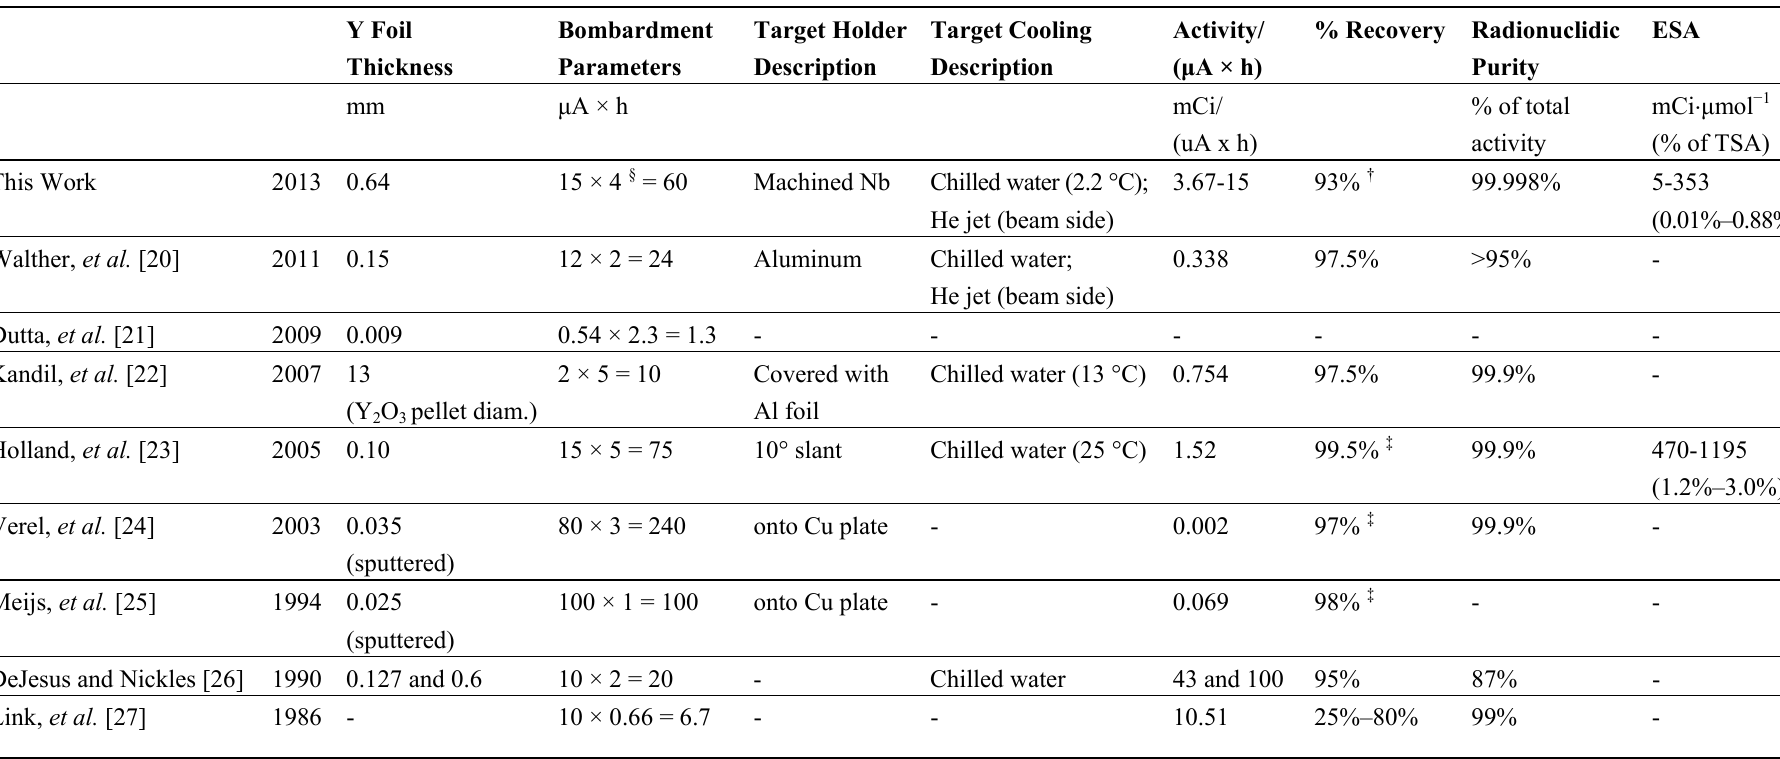
Table S1. Results from publications focused on 89 Zr production using the nat Y( p , n ) reaction route, sorted by publication date from newest to oldest. Y Foil Thickness